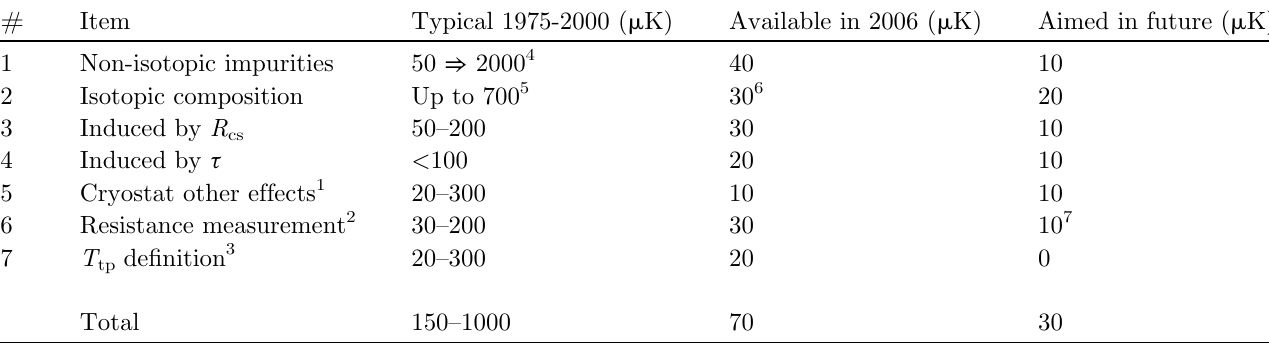
Table 1. Typical and aimed uncertainty budget for cryogenic fi xed point measurements